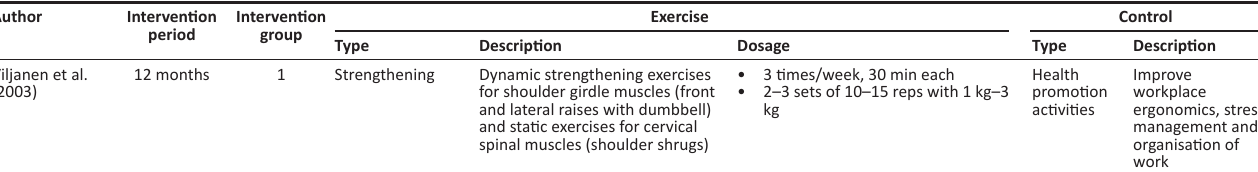
TABLE 3 (Continues...): Description of